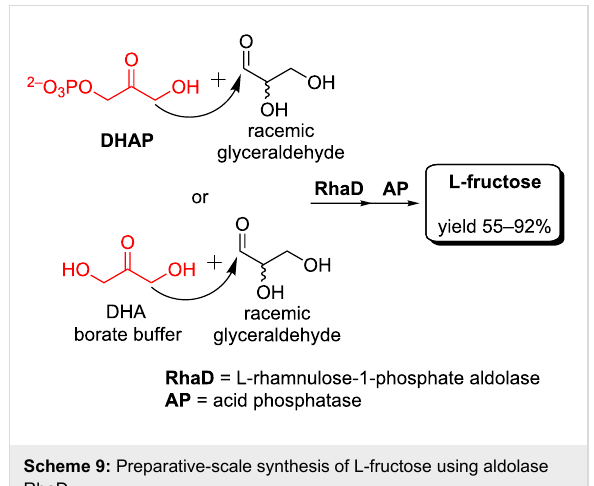
Scheme 9: Preparative-scale synthesis of L-fructose using aldolase